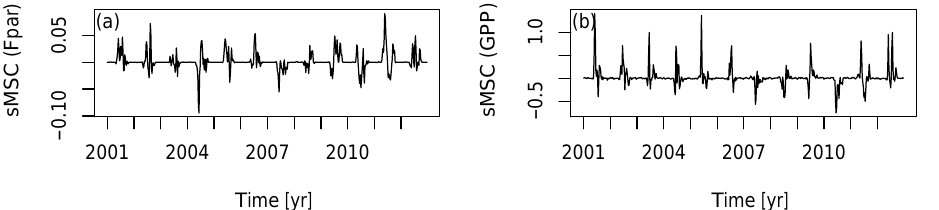
Figure 5. The residual time series obtained by subtracting the median seasonal cycle from (a) the fraction of absorbed photosynthetic radiation (fPAR) and (b) gross primary productivity (GPP) at northern latitudes exhibit heteroscedastic